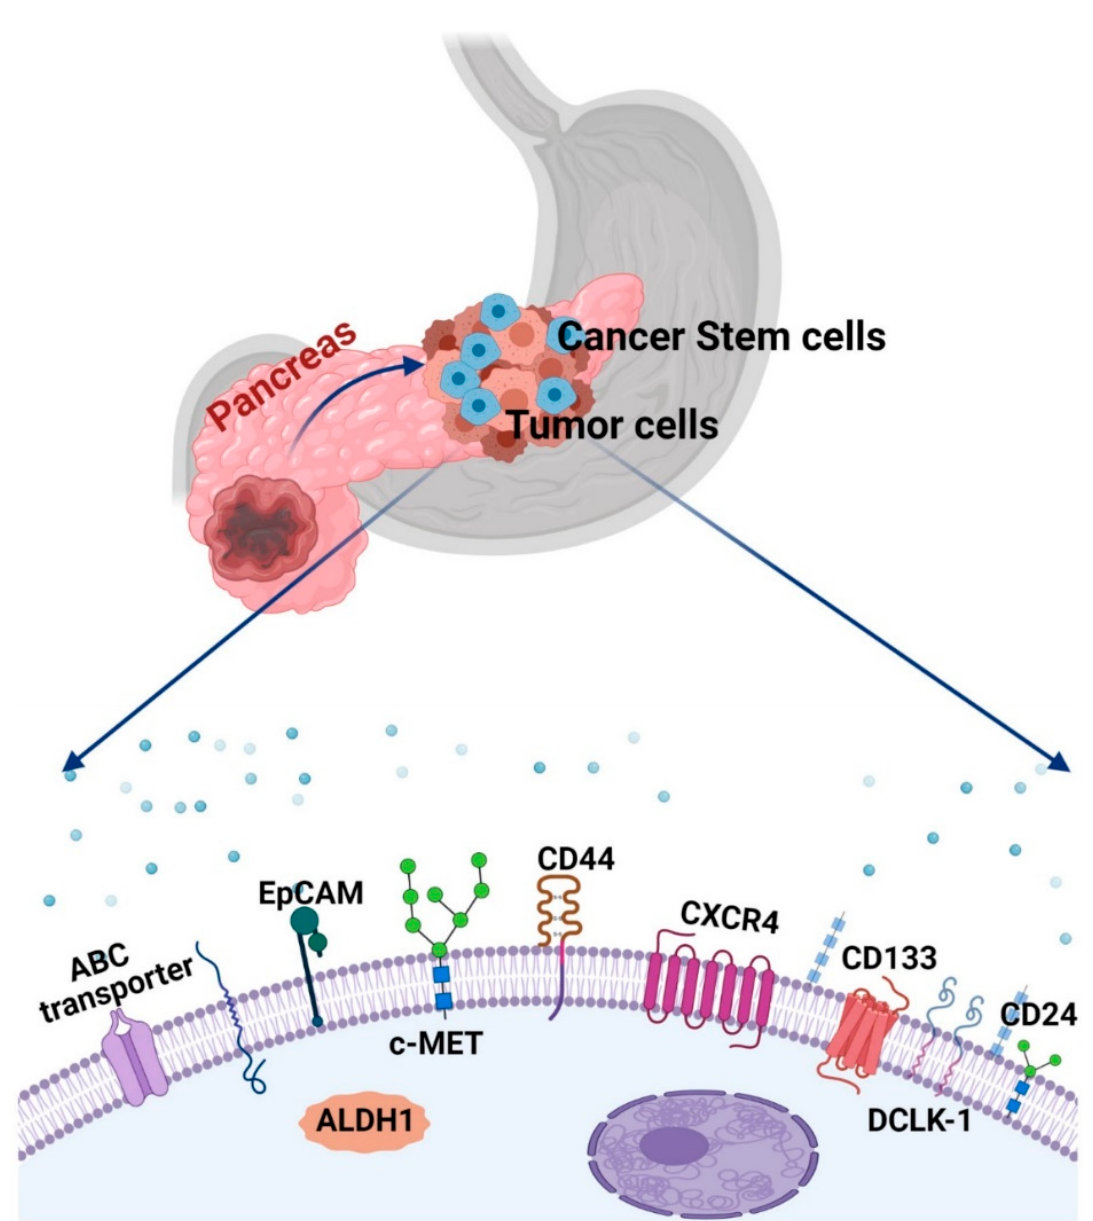
Figure 1. A schematic representation of distinct cancer stem cell populations in pancreatic cancer (PC). ATP-binding cassette (ABC); Epithelial cell adhesion molecule (EpCAM); Aldehyde dehydrogenase 1 (ALDH1); C-X-C Motif Chemokine Receptor 4 (CXCR4); Doublecortin-like kinase 1 (Dclk1).